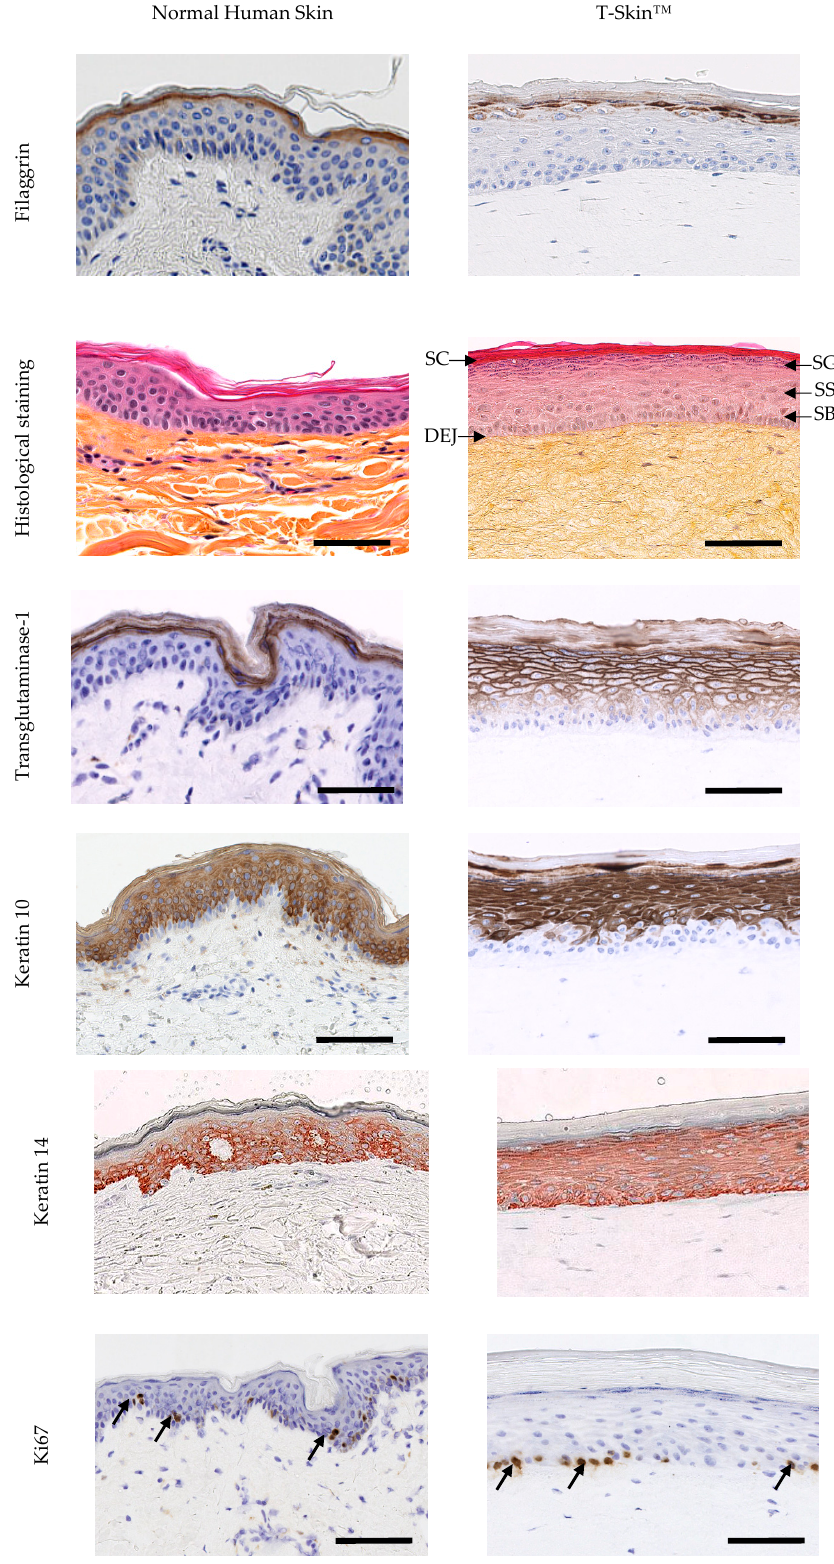
Figure 2. Characterization of the epidermis from normal human skin (NHS) and T-Skin™ by histology and immunohistochemistry analysis on paraffin sections. Localization on histological stained images of the stratum corneum (SC), stratum granulosum (SG), stratum spinosum (SS), stratum basal (SB) layers of the epidermis and the dermo–epidermal junction (DEJ). For histological staining, the scale bar represents 100 µm. All other bars are 100 µm. Arrows indicate positive cells for Ki67 expression